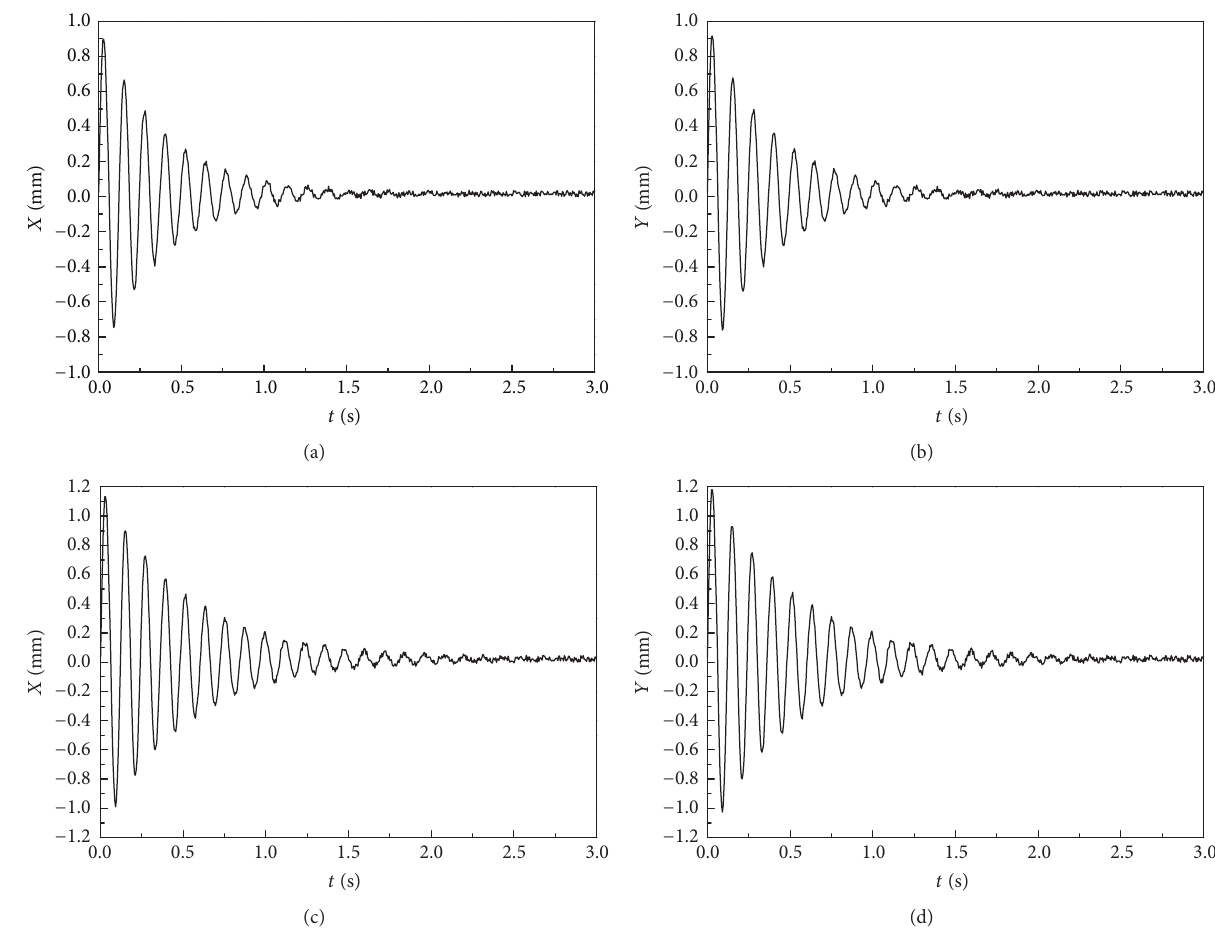
Figure 6: Time histories of the free vibrations of the monitored tubes in water. (a) Aluminum tube in the in-line direction, (b) aluminum tube in the transverse direction, (c) stainless steel tube in the in-line direction, and (d) stainless steel tube in the transverse direction.